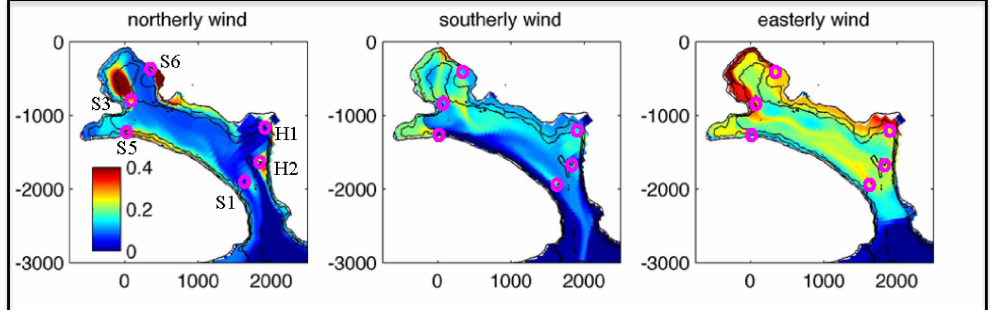
Figure 3. Distribution of dye concentration in the Guánica Bay model simulations with winds coming from North ( left ), South ( middle ); and East ( right ). Coordinates denote distance in meters. Dye concentration (color coded) is in mg/L. The realistic bathymetry shown in Figure 2 has been used. Magenta circles denote the release sites. Sites S1 and S3 correspond to the shipping channel. Site S5 corresponds to a release from the intertidal zone. S6 corresponds to the river outlet. H1 and H2 correspond to releases from the east embayment where extremely high levels of PCBs were